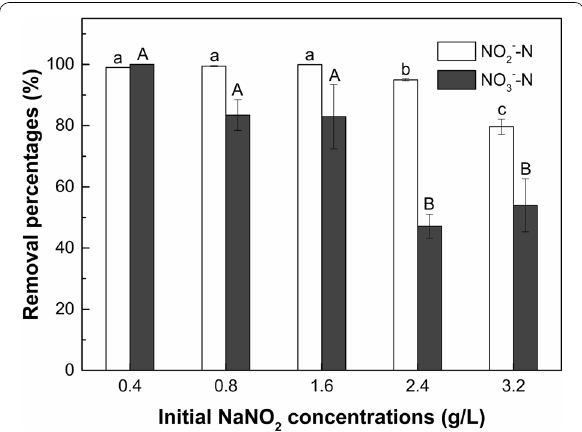
Fig. 7 Effect of inoculation size on denitrification capacity of strain F1 in saline condition (10 g/L NaCl). Values represent the mean of three replicates and error bars represent standard deviations. Columns containing different letters indicate significant differences among treatments at p < 0.05 by Tukey’s